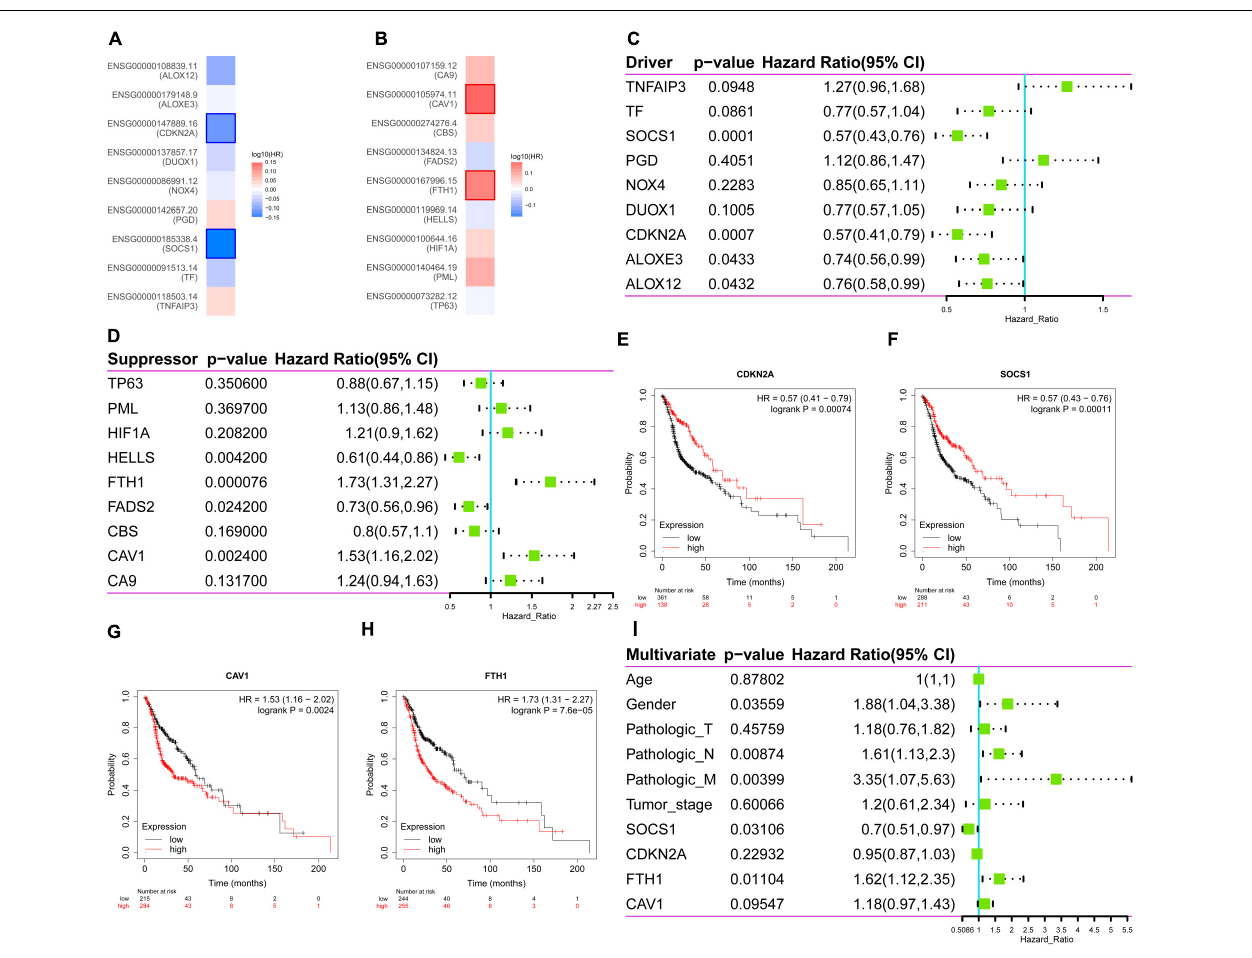
FIGURE 2 | Survival analysis of the expression levels of the ferroptosis driver and suppressor genes in HNSCC. (A) The ferroptosis drivers CDKN2A and SOCS1 correlated with longer overall survival (OS). (B) The ferroptosis suppressors CAV1 and FTH1 correlated with poorer OS. (C–H) Correlations between ferroptosis driver and suppressor genes and OS (Kaplan–Meier Plotter). (I) Multivariate Cox survival analysis showed that SOCS1 (HR 0.7, 95%CI 0.51–0.97, p < 0.05) and FTH1 (HR 1.62, 95%CI 1.12–2.35, p < 0.05) were independent prognostic factors for